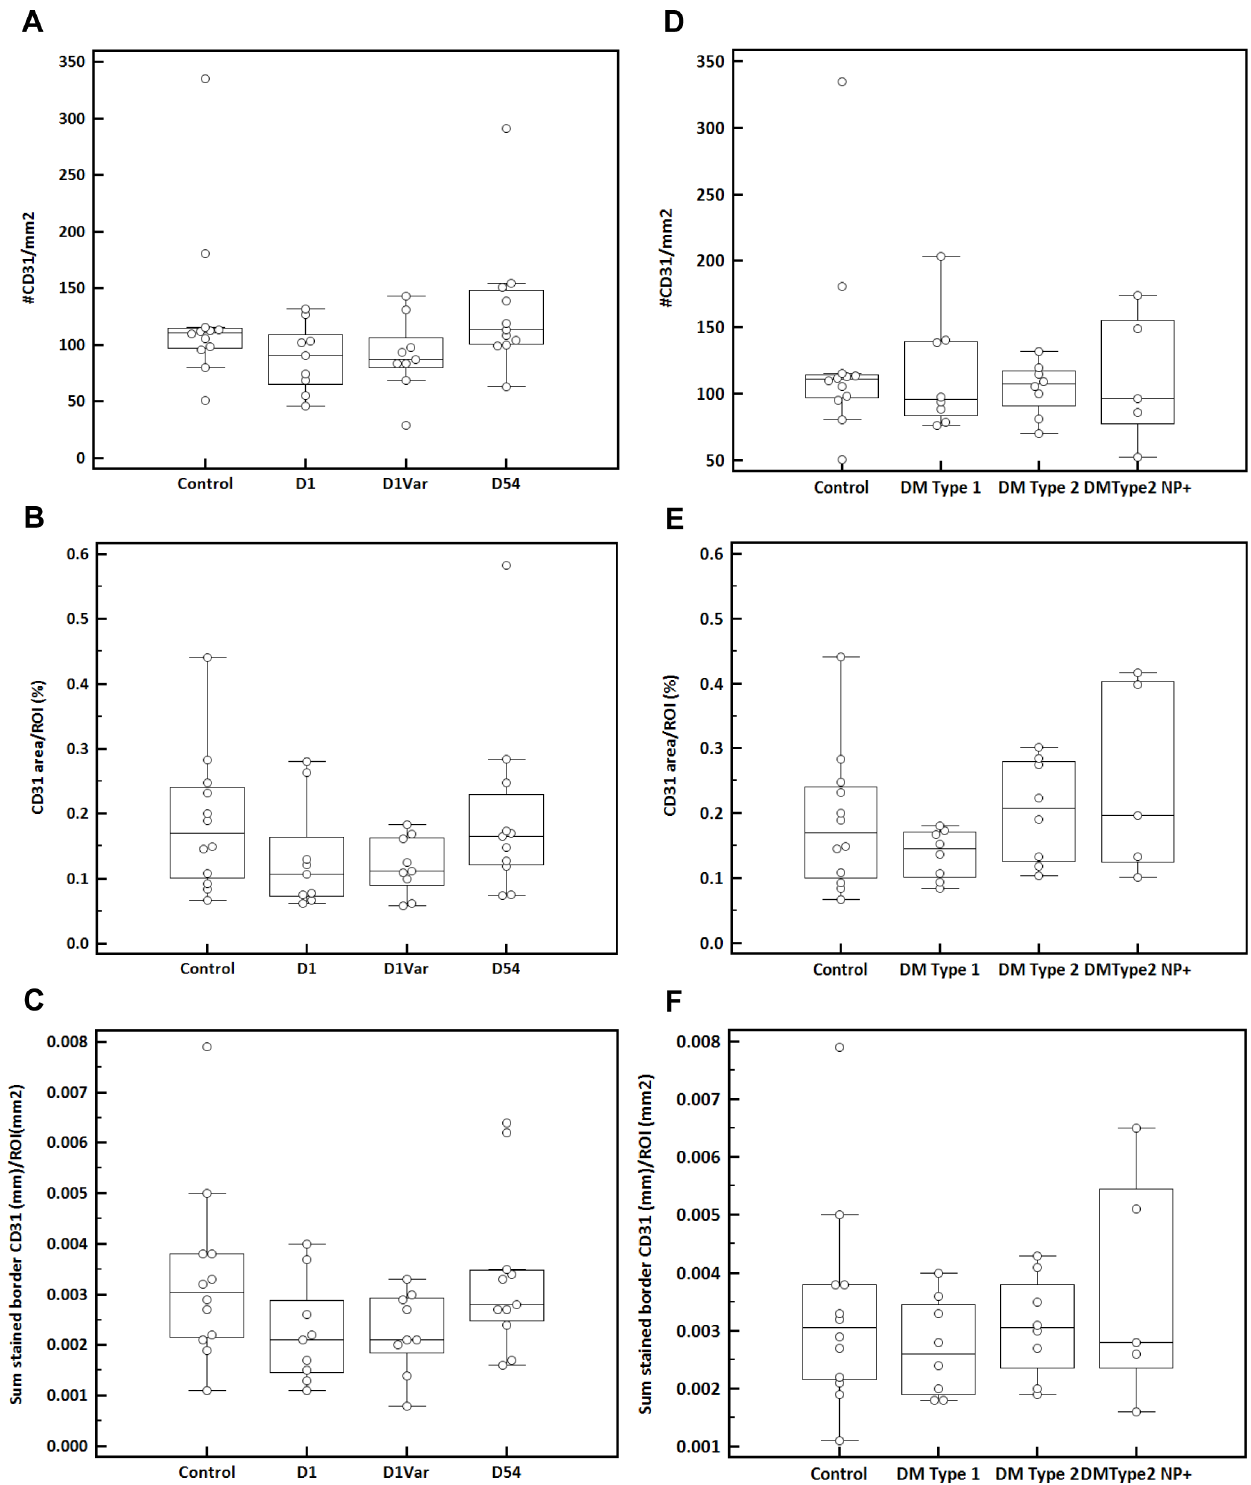
Fig 8. Definiens analysis of dermal vasculature. (A) Number of CD31 positive structures (#/mm2); (B) CD31 positive area/ROI (%); (C) Sum of CD31 positive border in dermis of controls, healthy volunteers who received topical capsaicin at day 1 (D1), a variable time point (Dvar) and day 54 (D54) after capsaicin was applied. (D) Number of CD31 positive structures (#/mm2); (E) CD31 positive area/ROI (%); (F) Sum of CD31 positive border in dermis of controls, diabetic subjects Type 1 (DM Type 1), Type 2 (DM Type 2) and diabetic subjects suffering from polyneuropathy (DM Type 2